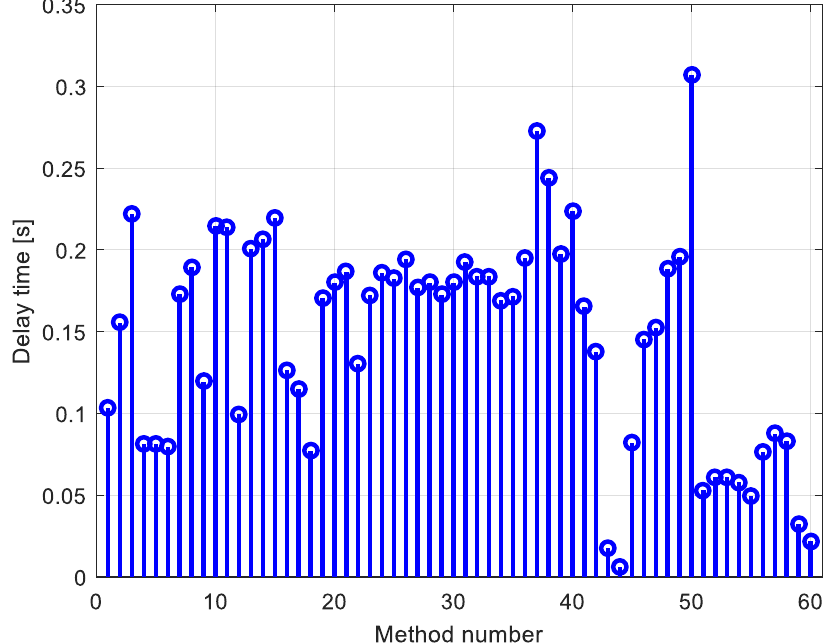
Figure 3. Delay time of the generator voltage.